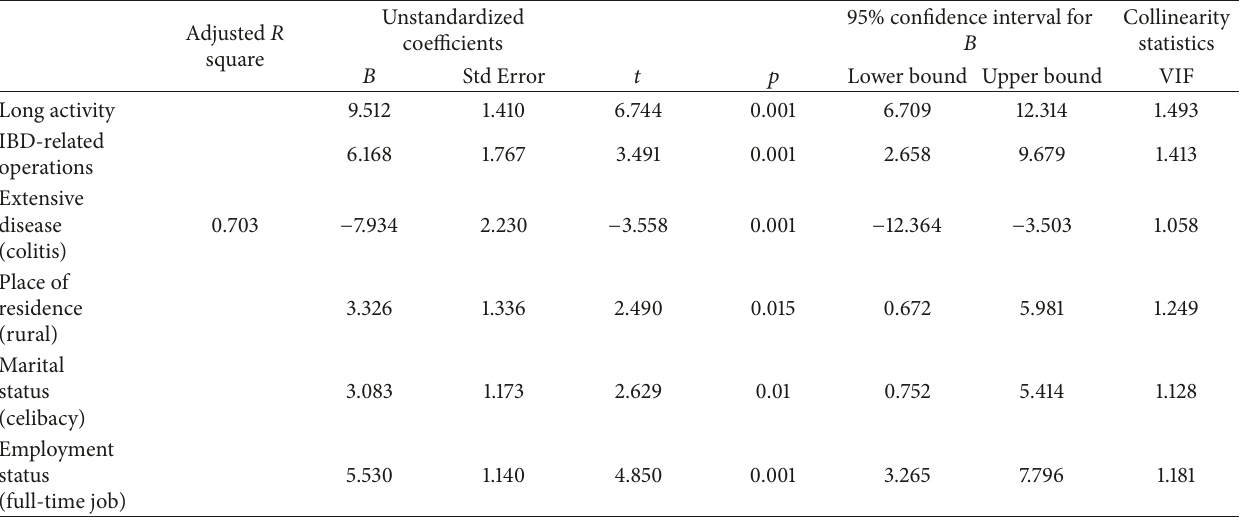
Table 5: Predictors for increased overall disability among population characteristics on the basis of multiple linear regressions in patients with Crohn’s disease.